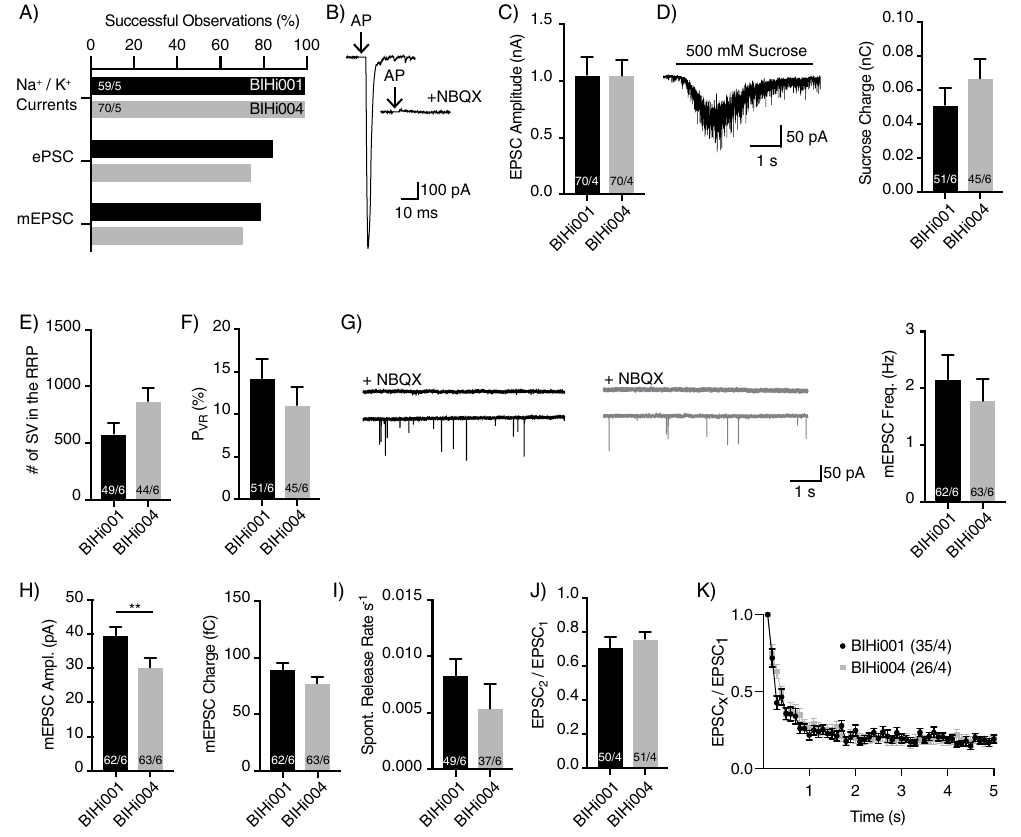
Figure 3. AP-evoked and spontaneous NT release and vesicular release probability of autaptic iNs. ( A) Fraction of neurons which showed membrane voltage-dependent K + and Na + /Ca 2 + currents, EPSC and mEPSC in autaptic hiN cells. ( B) Representative traces of AP-evoked EPSCs recorded in the absence or presence of the AMPA receptor antagonist NBQX. ( C ) Mean AP-evoked EPSC amplitudes of iNs induced from BIHi001- and BIHi004-iPSCs. ( D ) Exemplary trace of the synaptic response of an autaptic iN elicited by 500 mM hypertonic sucrose solution (left) and average size of the RRP charges (right). ( E,F) Number of SVs in the RRP ( E ) and mean P VR ( F ). ( G) Exemplary mEPSCs recorded from autaptic iNs in the absence or presence of NBQX (left) and mean mEPSC frequencies in BIHi001- and BIHi004-derived iNs (right). ( H) Mean amplitudes and charges of mEPSCs. ( I) Spontaneous release rate of human autaptic iNs. ( J) Average paired-pulse ratios (PPR) calculated from two EPSCs with an ISI of 25 ms. ( K) Normalized EPSC amplitudes during a 10 Hz train stimulation. AP artefacts were blanked and are indicated by black arrows. The numbers of neurons and independent cultures analysed are shown within the bars. Data are expressed as mean ±